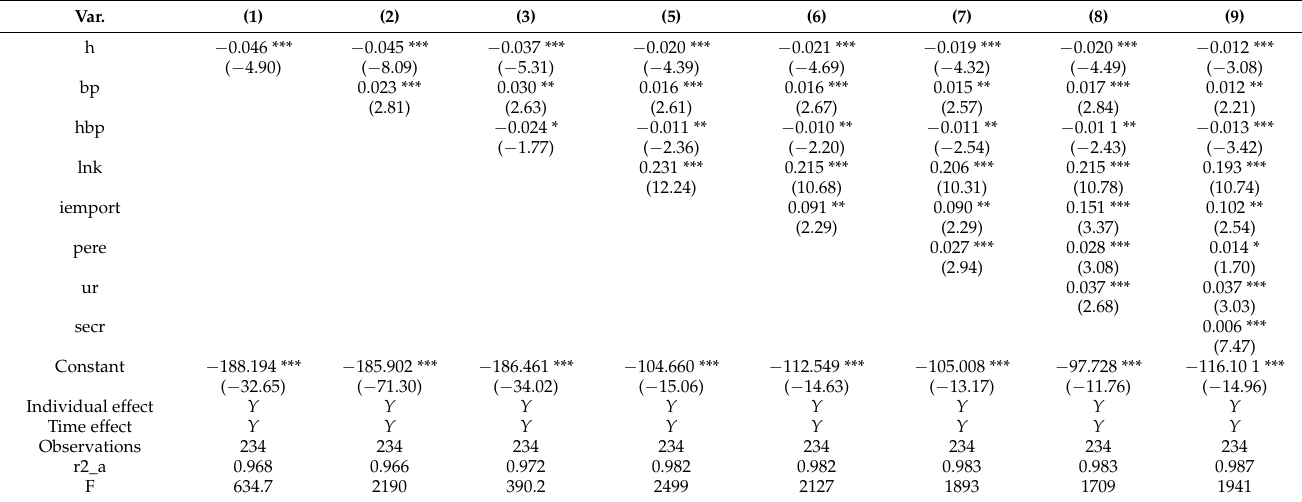
Table 2. Results of step-to-step regression estimation of panel fixed effect